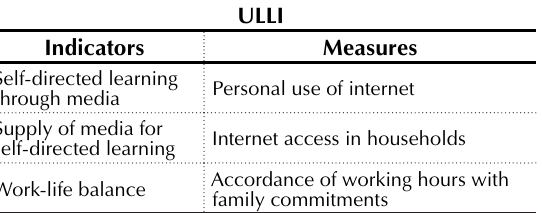
Table 5 (cont.). The adapted dimension of learning to